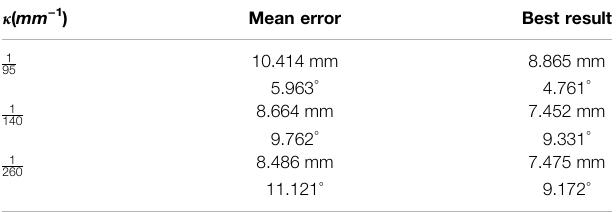
TABLE 2 | Results of rotational deformation.